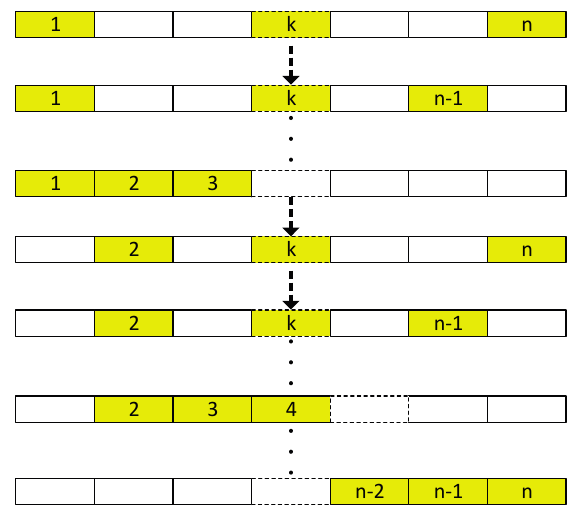
Figure 5. Logic diagram of a loop